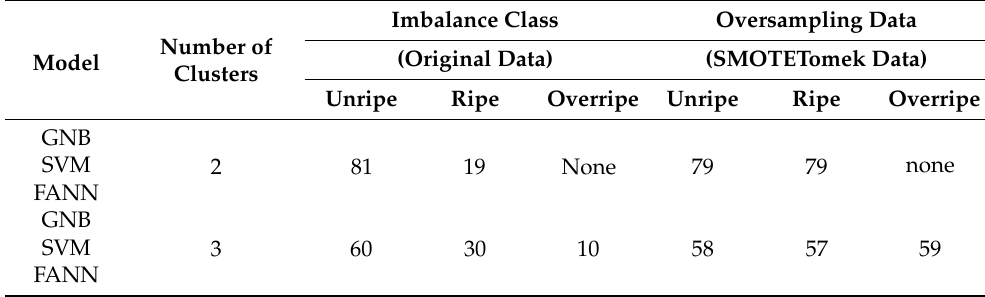
Table 4. Comparison of the original data and oversampling data for training ML